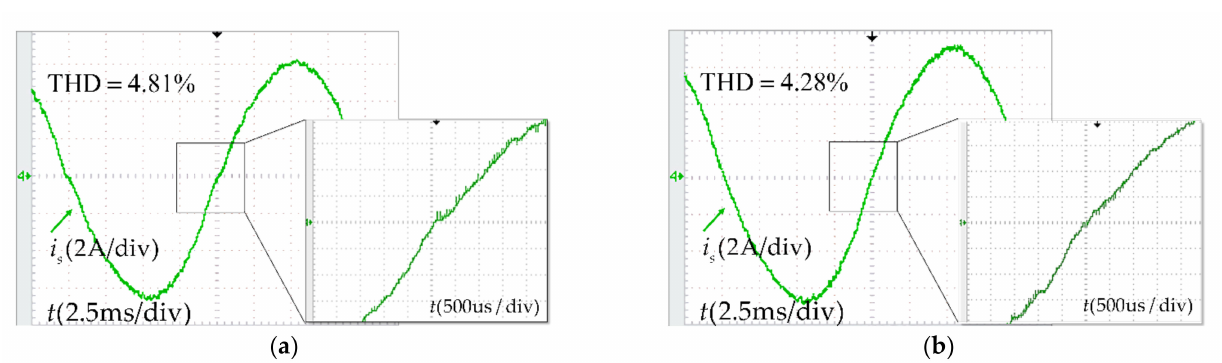
Figure 19. The current waveform when the dead time is 2 µ s. ( a ) No compensation ( b ) With compensation.